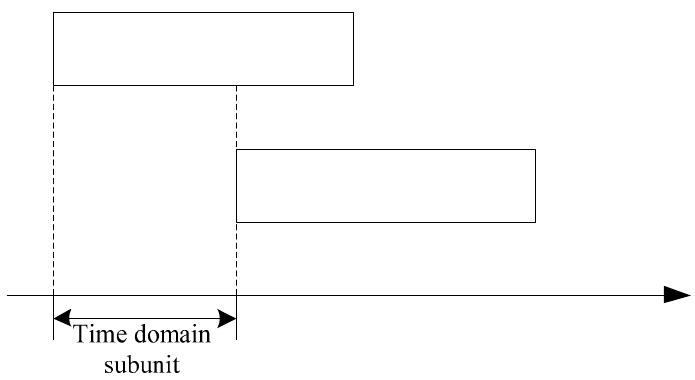
Figure 1. Time domain window structure.